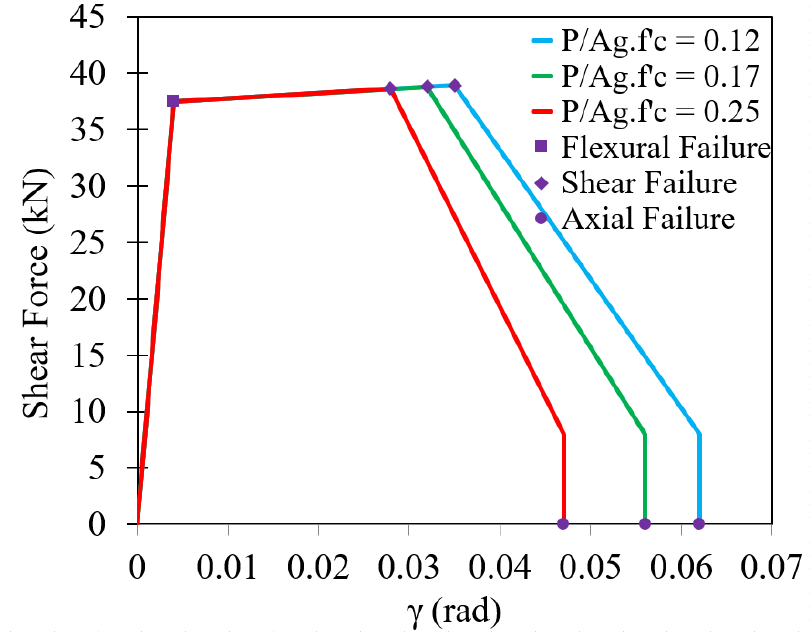
Fig. 7. Shear Force Vs. Rotation curves for the columns in 3 story frame according to the variation of initial axial load ratios (ASCE/SEI